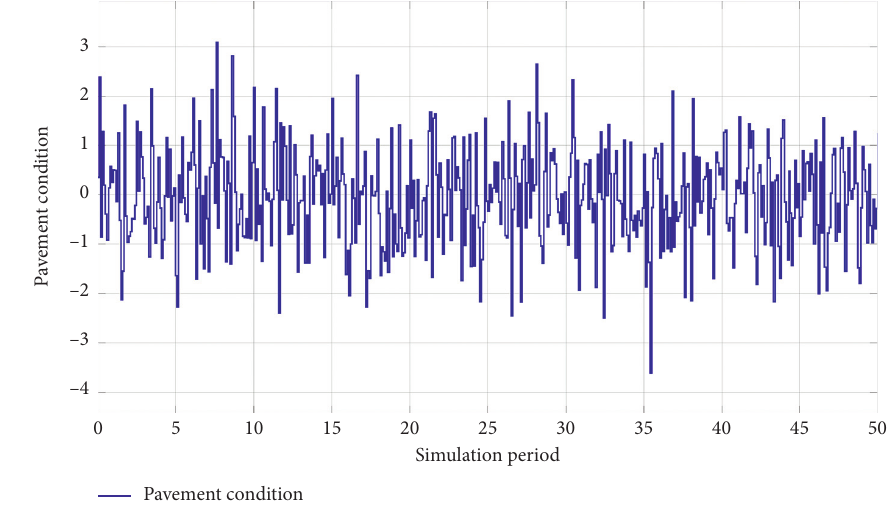
Figure 4: Pavement condition.